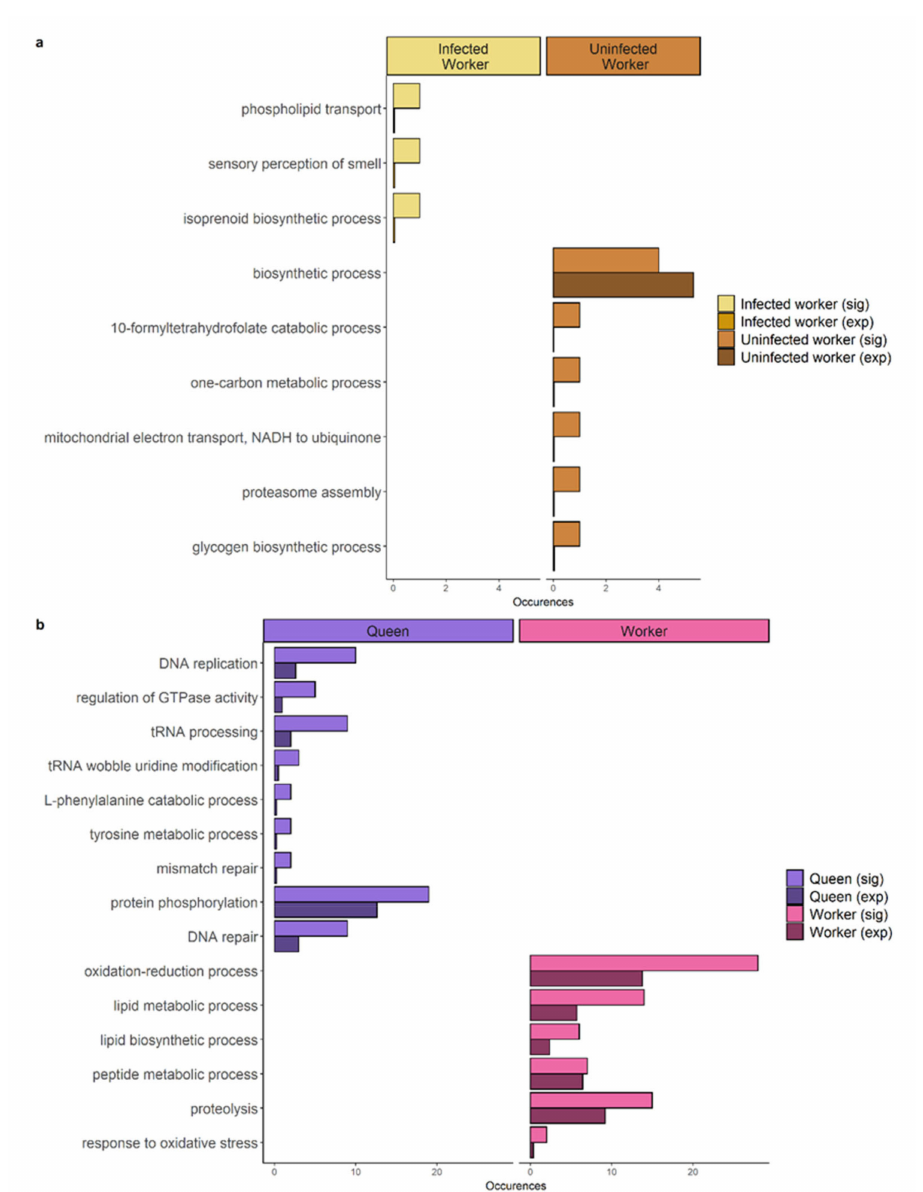
Figure 4. Bar plots depicting the significantly enriched Gene Ontology terms upregulated in ( a ) ants from parasitized nests: infected workers (left panel) and uninfected workers from parasitized nests (right panel). ( b ) ants from unparasitized nests: queens (left panel) and workers (right panel). Number of genes annotated with the specific term found in the candidate gene list are depicted (sig) as well as the number expected in a list of this size based on the annotation of the whole transcriptome